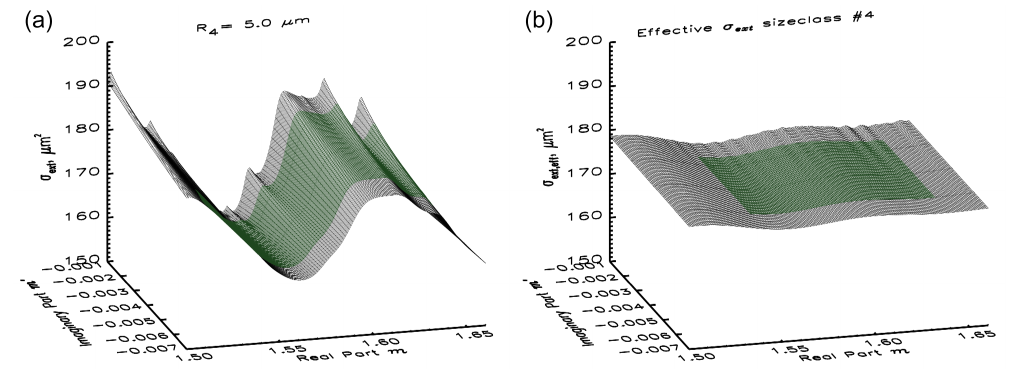
Figure 4. Sensitivity of σ ext to the real and imaginary part of the refractive index for a single particle radius R p of 5µm (a) and after calculating the effective extinction cross section σ ext for size class 4 (b) . The green shaded area is the considered range of real part m and imaginary part m (cid:48) for the uncertainty estimation as explained in Sect. 4.1.